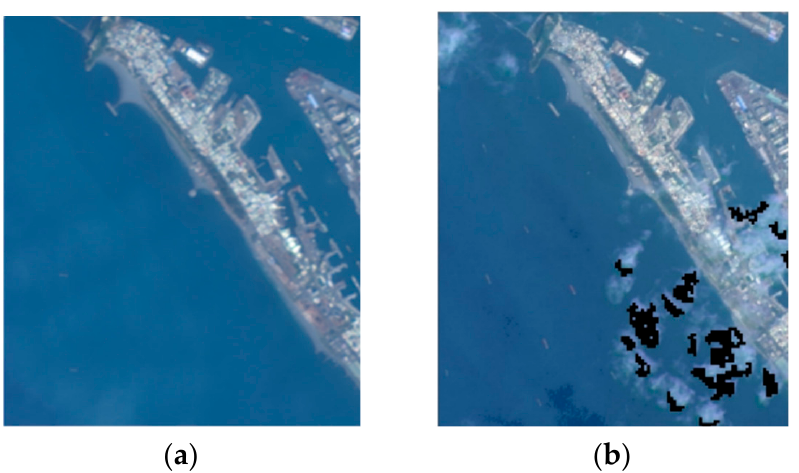
Figure 8. Kaohsiung Port: ( a ) Color image; ( b ) Cloud removal image.